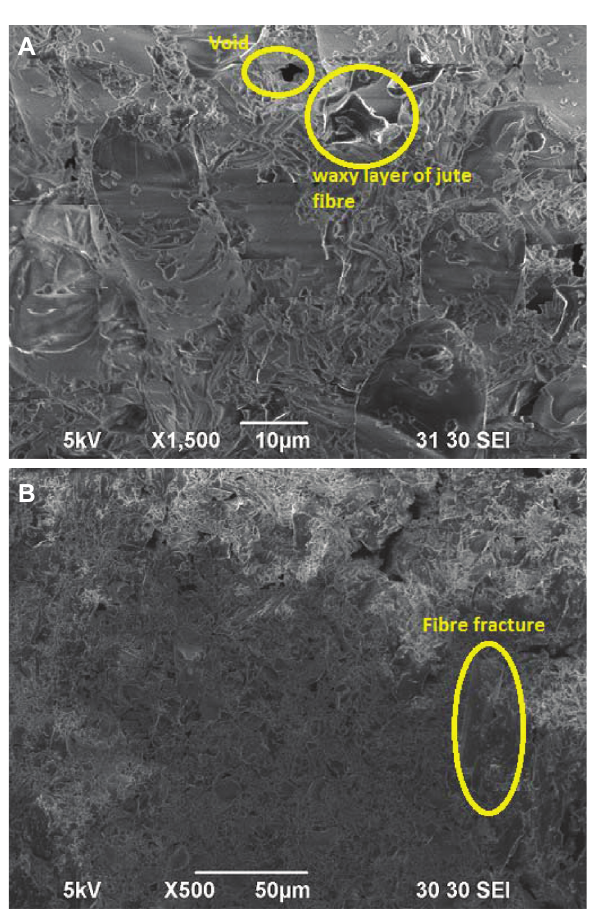
Figure 6 Fractography image of flexural strength-tested specimen. Figure 7 Effect of the fiber percentage on impact